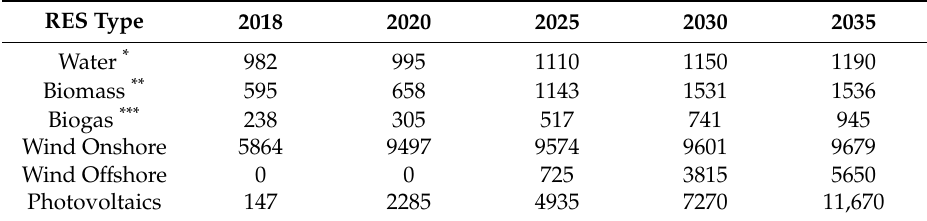
Table 4. Renewable energy sources (RES) installed capacity (MW).